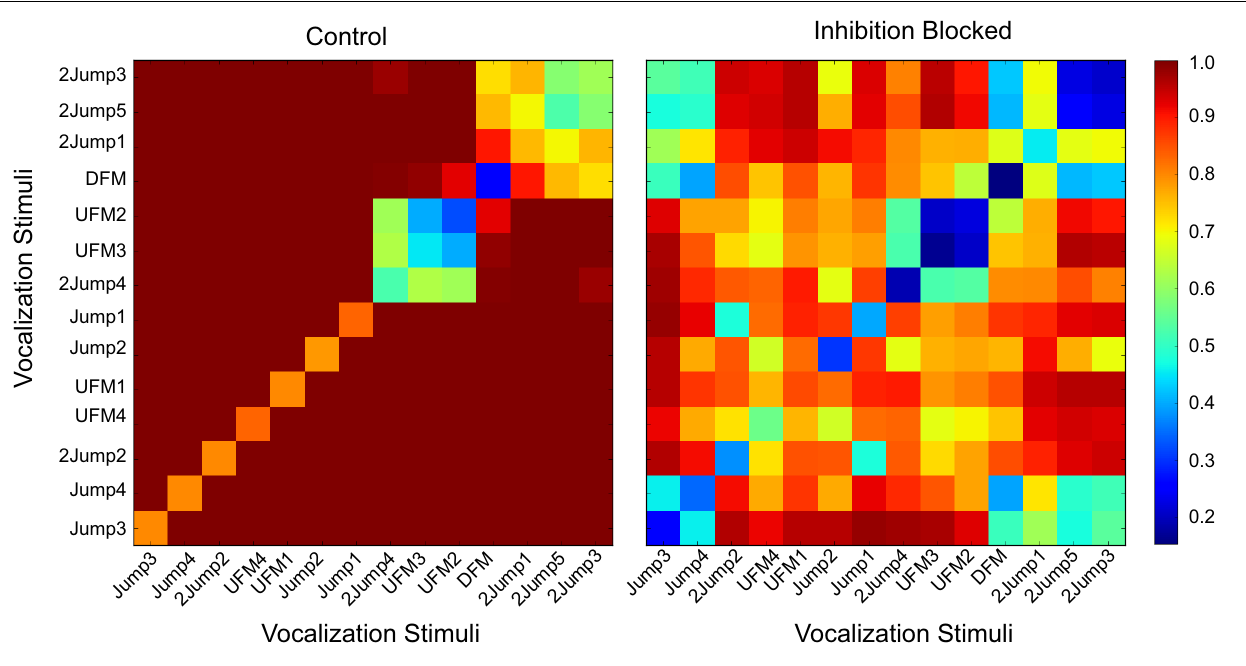
FIGURE 9 | Dissimilarity matrices for a modified neuron under control (left panel) and inhibition-blocked (right panel) conditions. The response patterns of the neuron broaden with the blocking of inhibition, and become in